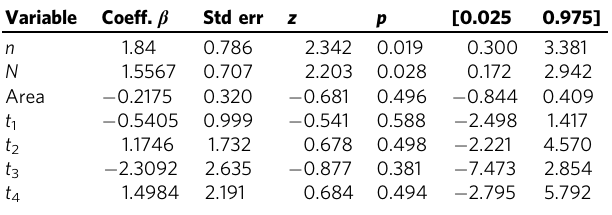
Table 1 Generalized linear model (GLM) 42 results (number of samples is 96) from the statsmodel API 45 . Variable Coeff.